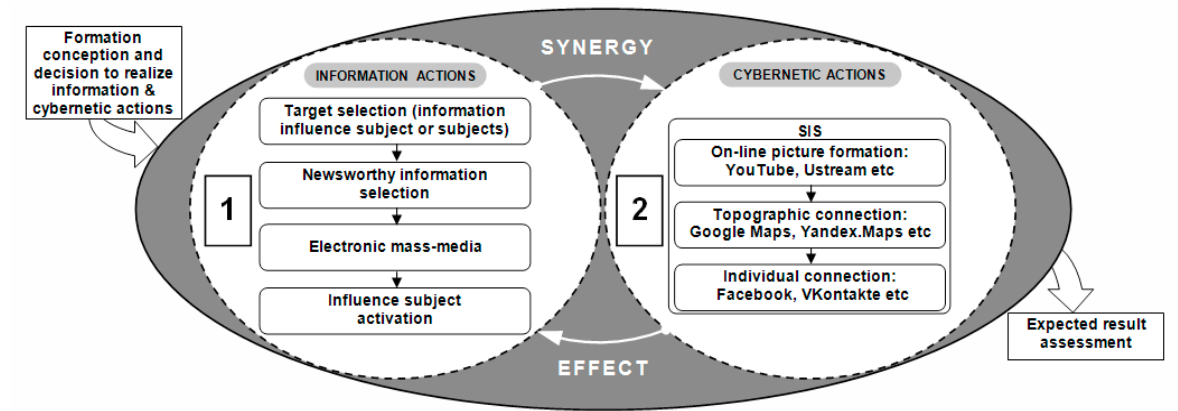
Fig. 1. Typical technology of a synergistic effect generation caused by information and cybernetic